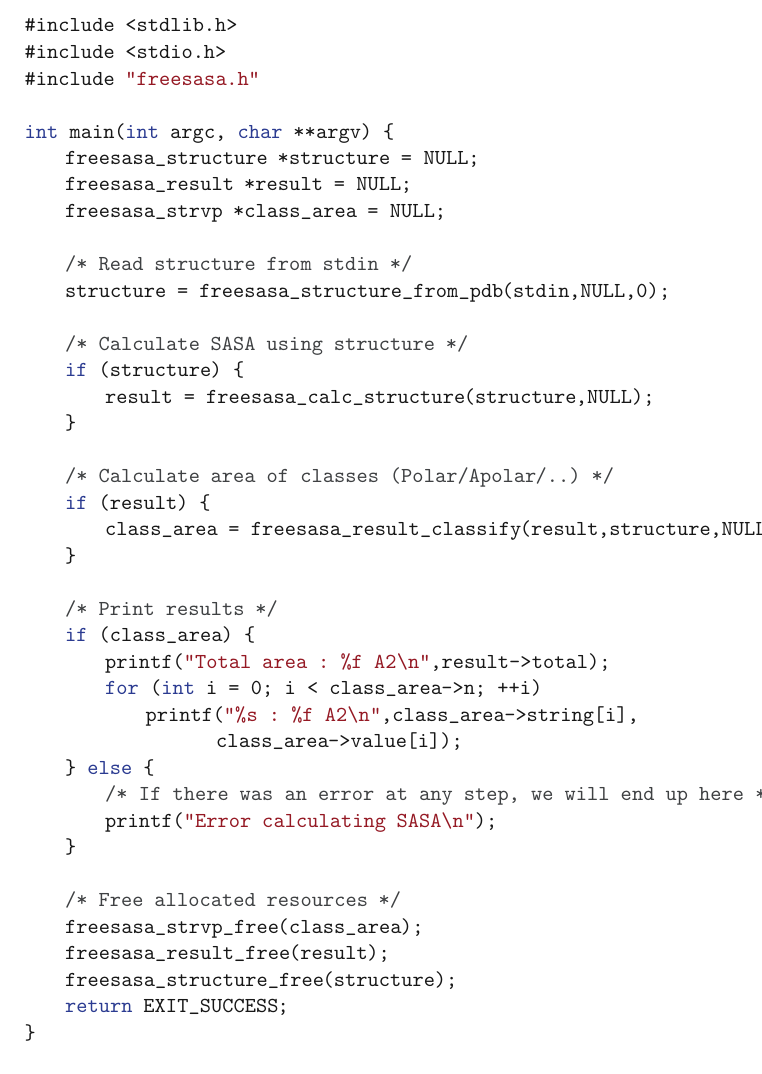
Figure 1. C API. Illustration of how to use the C API including rudimentary error handling.